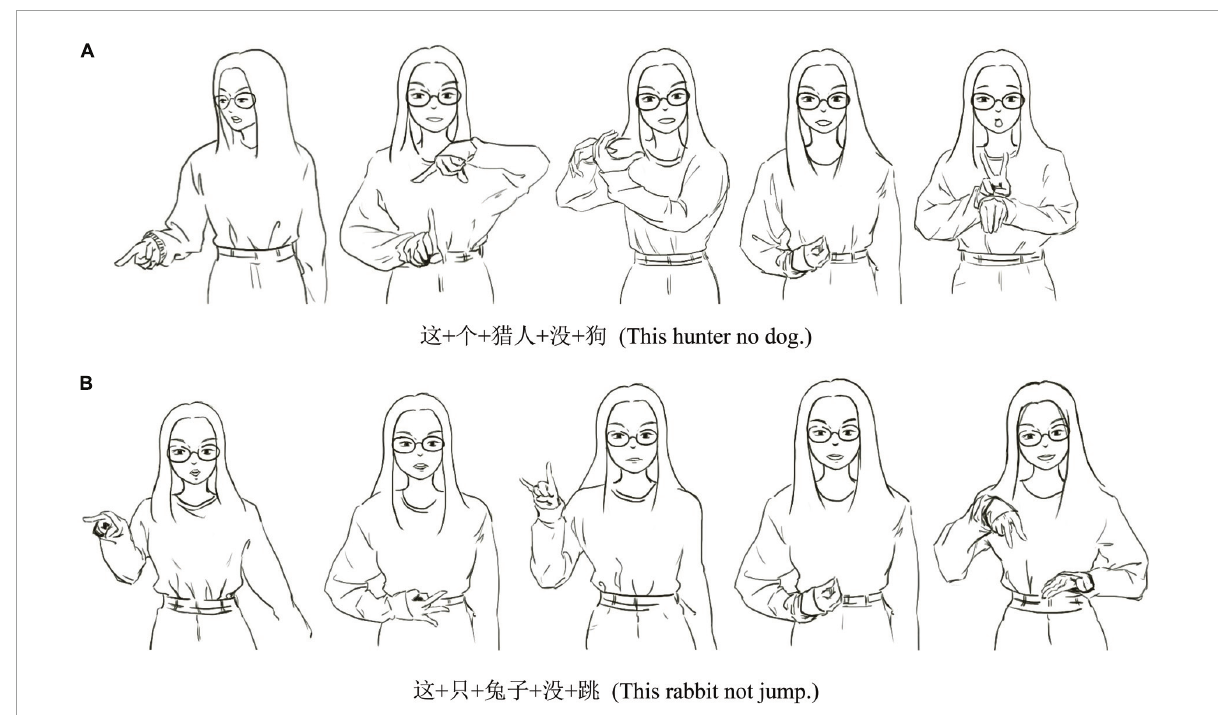
FIGURE2 Illustrated examples of the CSL stimuli, which were performed by an